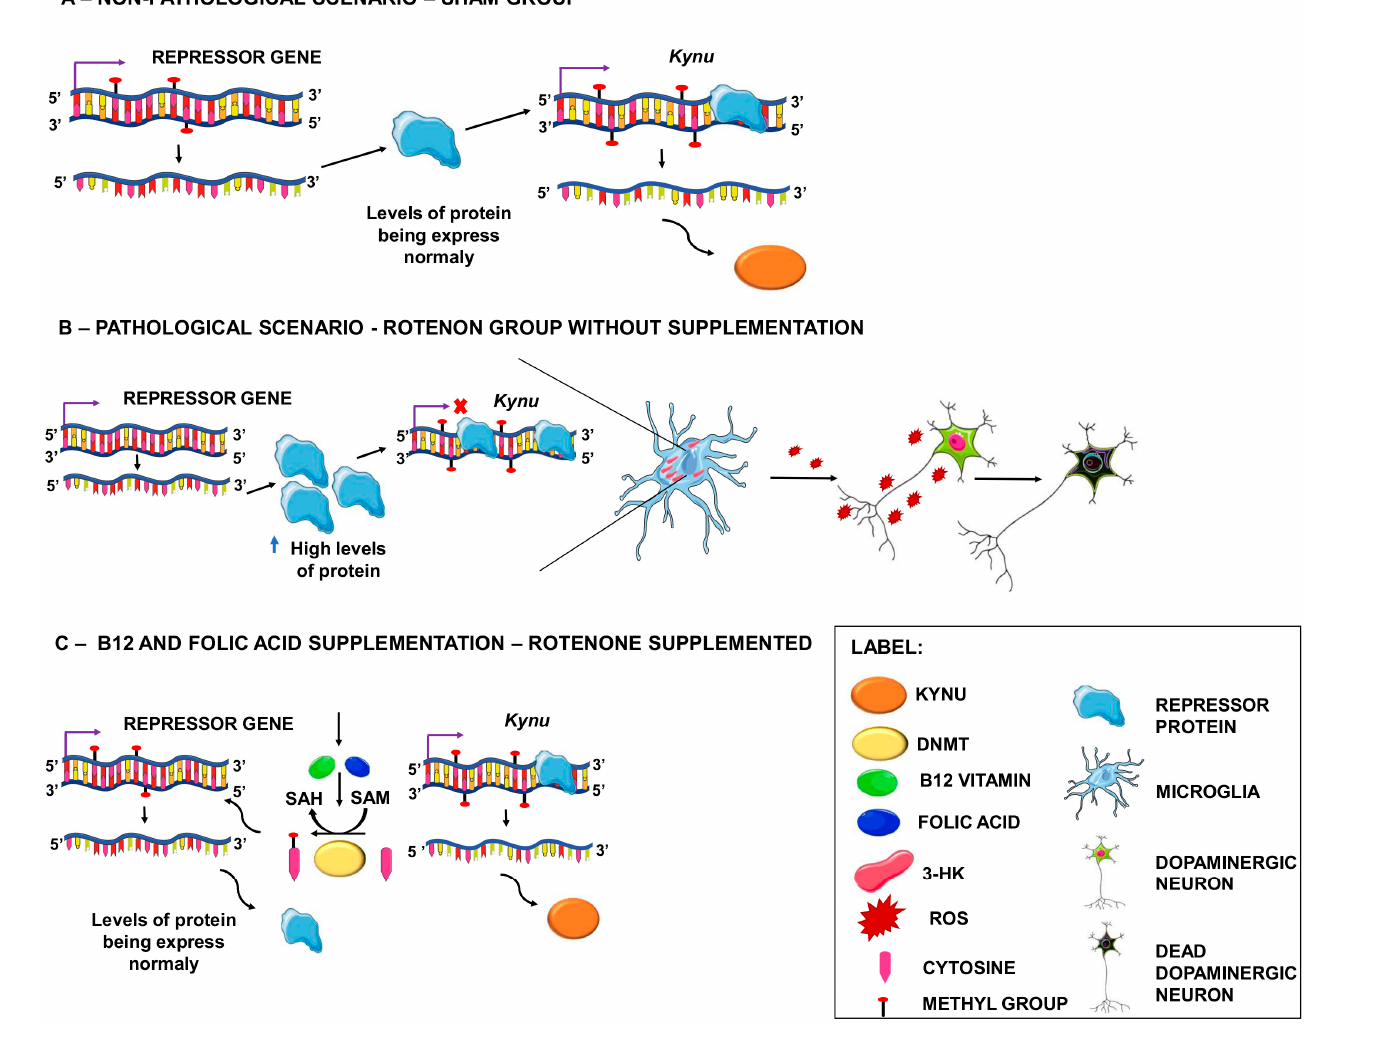
Figure 4. Effects of folic acid and vitamin B12 supplementation on Kynureninase expression. ( A ) In a non-pathological scenario, Kynu is possibly expressed at normal levels, as well as the repressor protein, which does not have sufficient levels to completely suppress Kynu expression. ( B ) In a pathological scenario, this repressor may have a hypomethylated promoter region, leading to continuous expression and increased protein levels, resulting in intense Kynu repression. KYNU can process 3-hydroxykynurenine (3-HK), and low levels of this enzyme may trigger the accumulation of 3- HK, resulting in a toxic effect due to the generation of free radical superoxide and hydrogen peroxide, which leads to cell death. ( C ) With folic acid and B12 supplementation, the DNA methylation process is normalized, and the repressor’s promoter region returns to its standard methylation state or becomes completely methylated, reducing or silencing the expression of this repressor and allowing for Kynu expression to occur and 3-HK to be appropriately